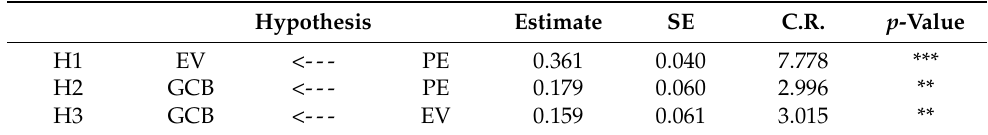
Table 4. Results of the hypothesis